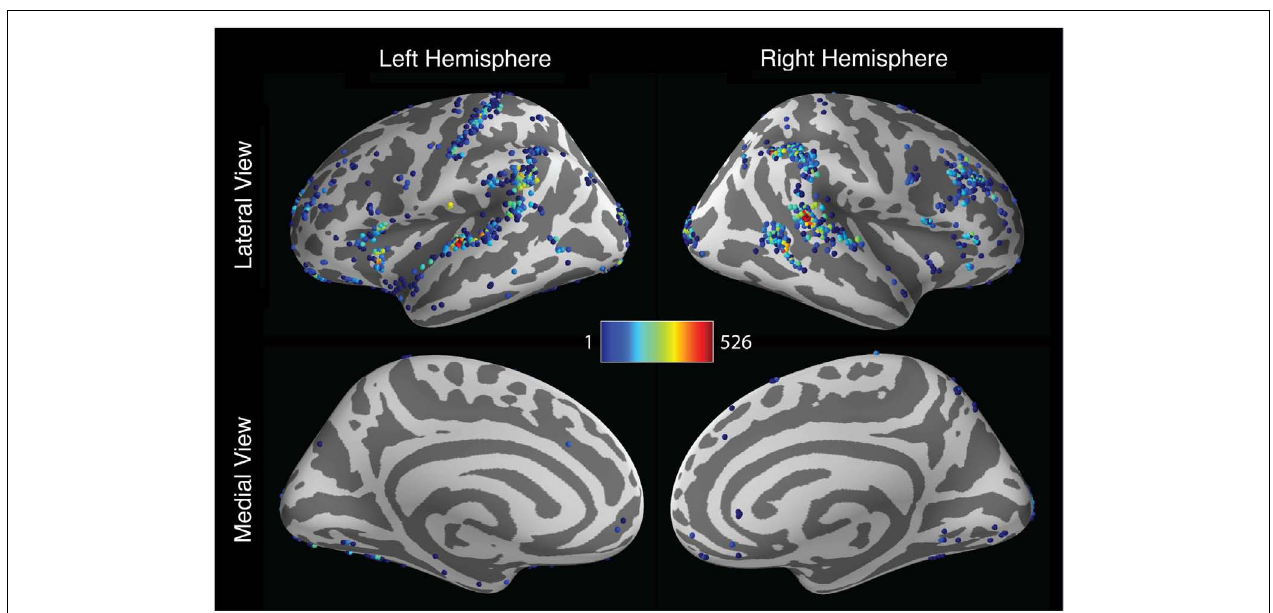
logarithm of the number of pipelines yielding maximal activation for that location; colors range from blue, indicating a single pipeline, to red, indicating 526 pipelines.